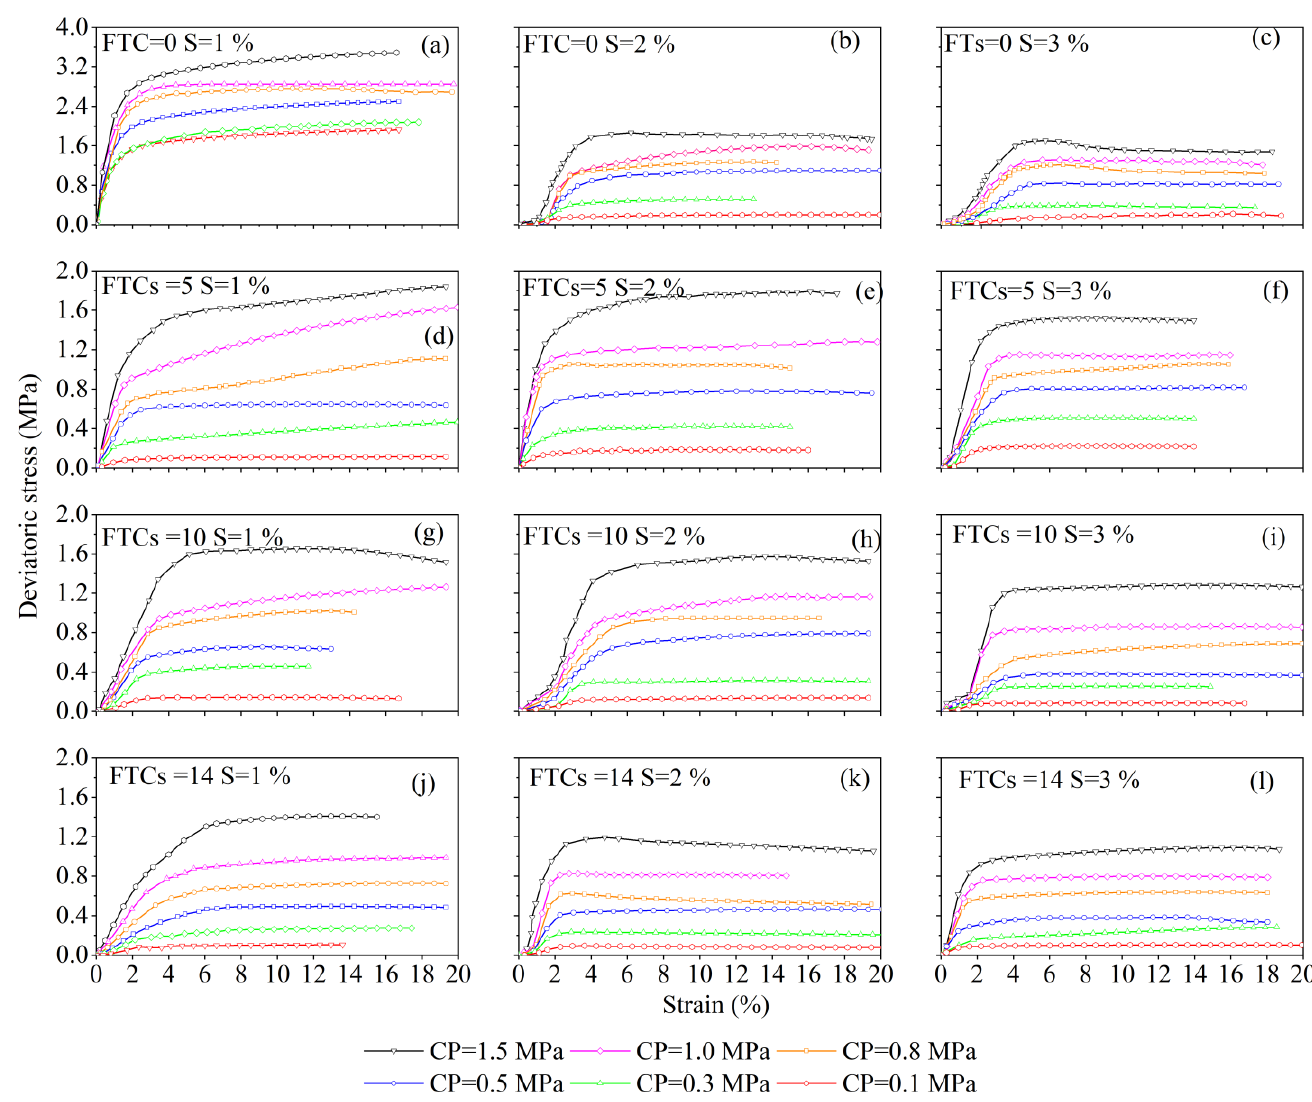
Figure 4. Bias stress–axial strain curves for different freeze–thaw cycles and different salinity content. Notes: FTCs represents freeze–thaw cycles, S represents salinity, and CP represents confining pressure.